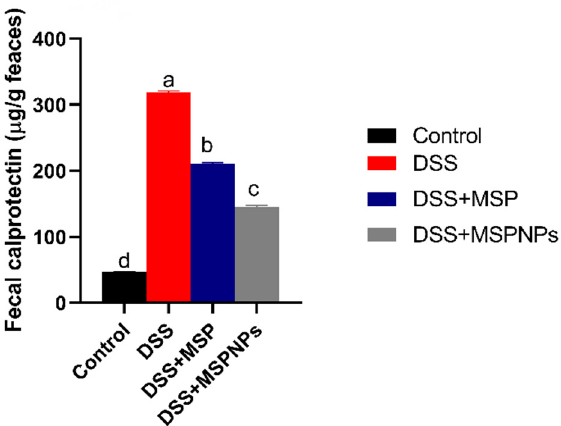
Figure 3. Effects of orally administered free multi-strain probiotics (MSPs) or multi-strain-probiotic- loaded nanoparticles (MSPNPs) on fecal calprotectin levels 14 days post DSS induction. Non-colitic group: Control (rats were orally gavaged with PBS). Colitic groups including: DSS (rats were orally gavaged with dextran sodium sulphate), DSS + MSPs (rats were orally gavaged with DSS and multi- strains probiotics (MSPs) at the level of 1.0 × 10 10 CFU/kg in 1 mL of PBS/rat/day for 14 days), DSS + MSPNPs (rats were orally gavaged with DSS and multi-strain-probiotic-loaded nanoparticles (MSPNPs) at the level of 1.0 × 10 10 CFU/kg in 1 mL of PBS/rat/day for 14 days); all groups were orally gavaged with 5% DSS. Values are expressed as mean ± SE, a,b,c,d Means of the bars with different letters were significantly different among groups ( p < 0.05).